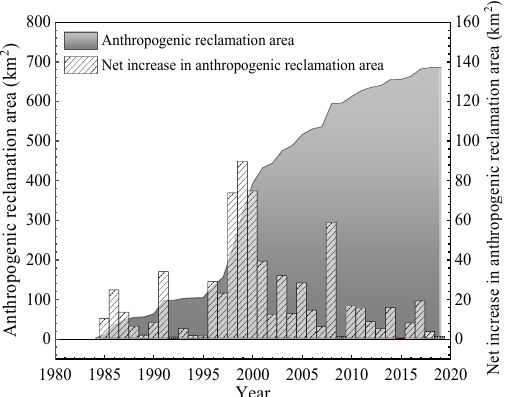
Figure 6. Change of anthropogenic reclamation area around the Abandoned Yellow River Delta.